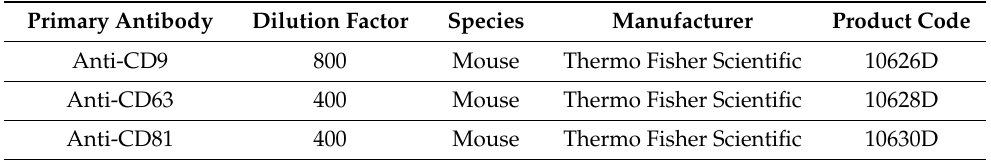
Table 1. Primary antibodies for dot